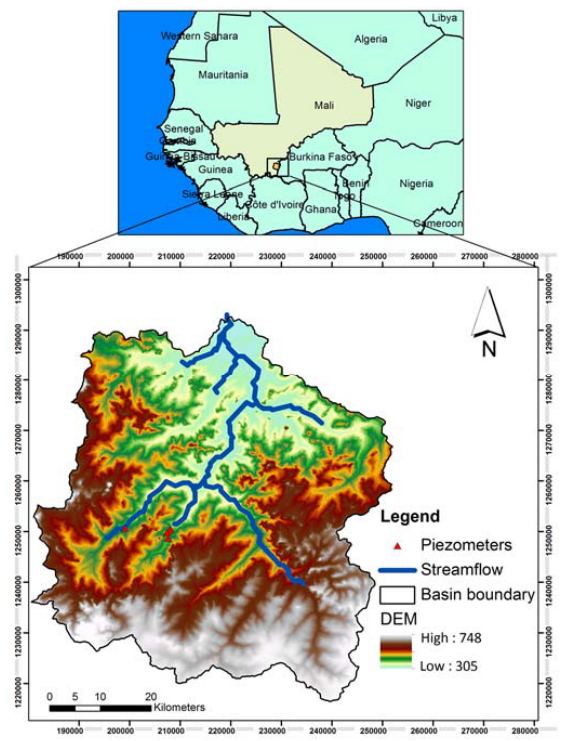
Figure 1. Geographical location of the Klela basin in southern Mali (Toure et al. [6]).